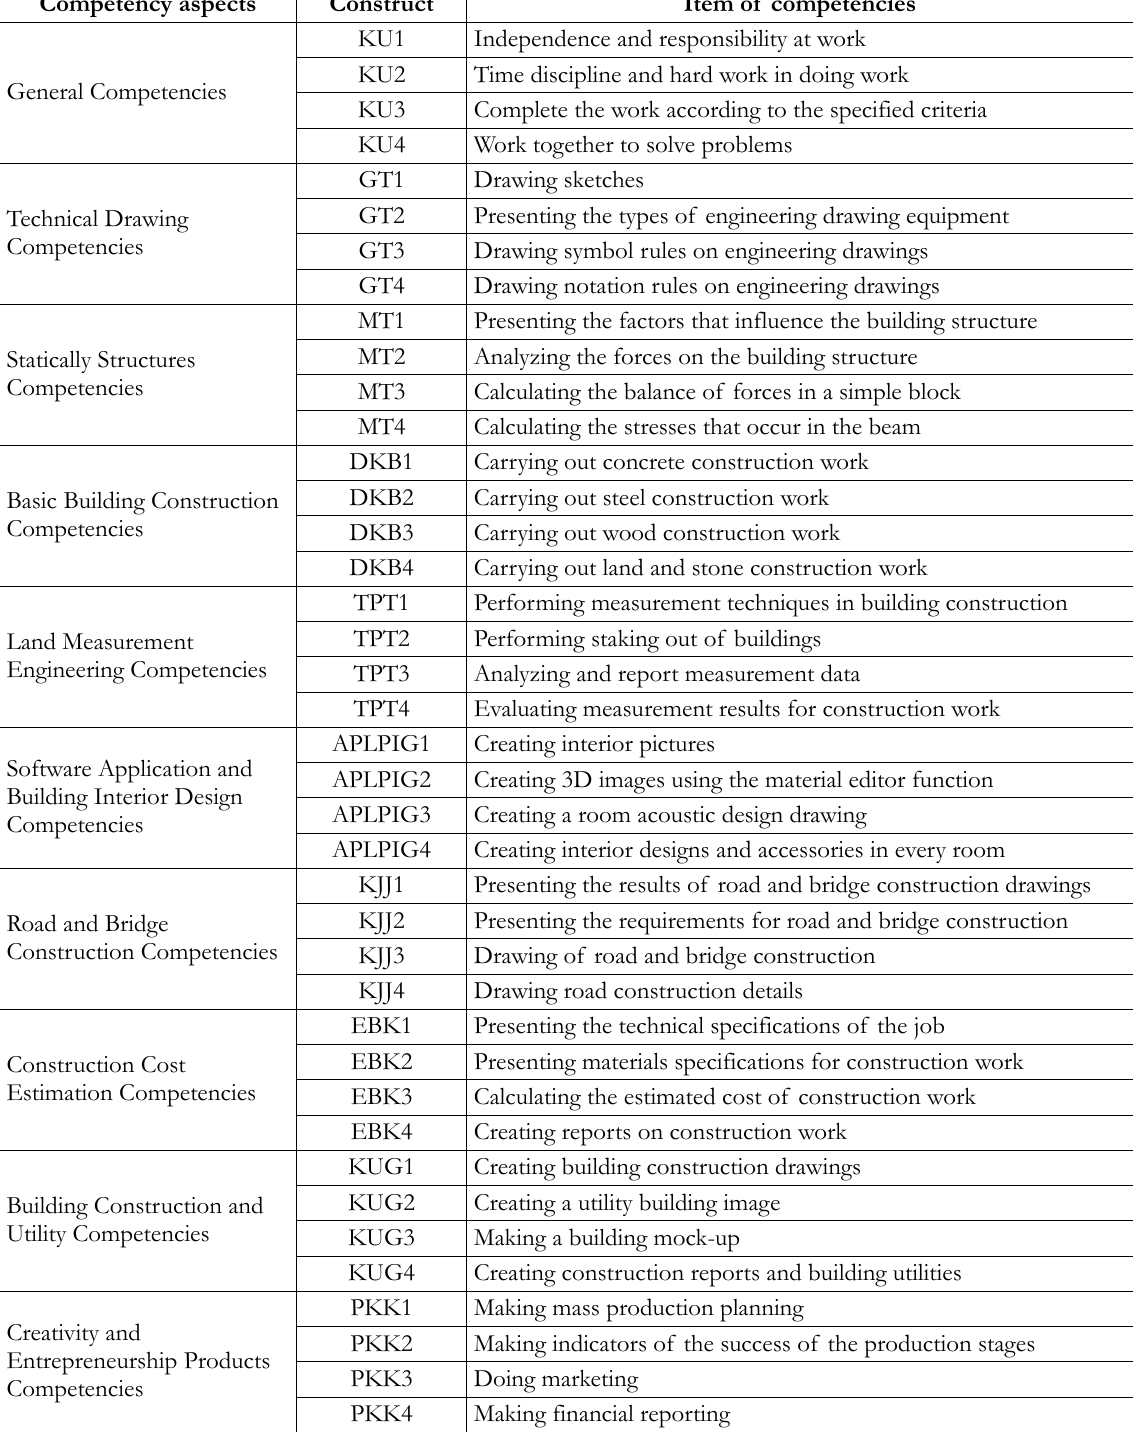
Table 2. Architectural engineering competencies in the Indonesian